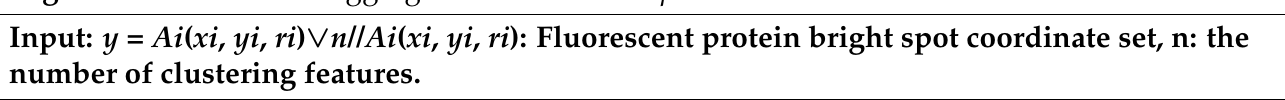
Algorithm 1. Calculate Aggregation information